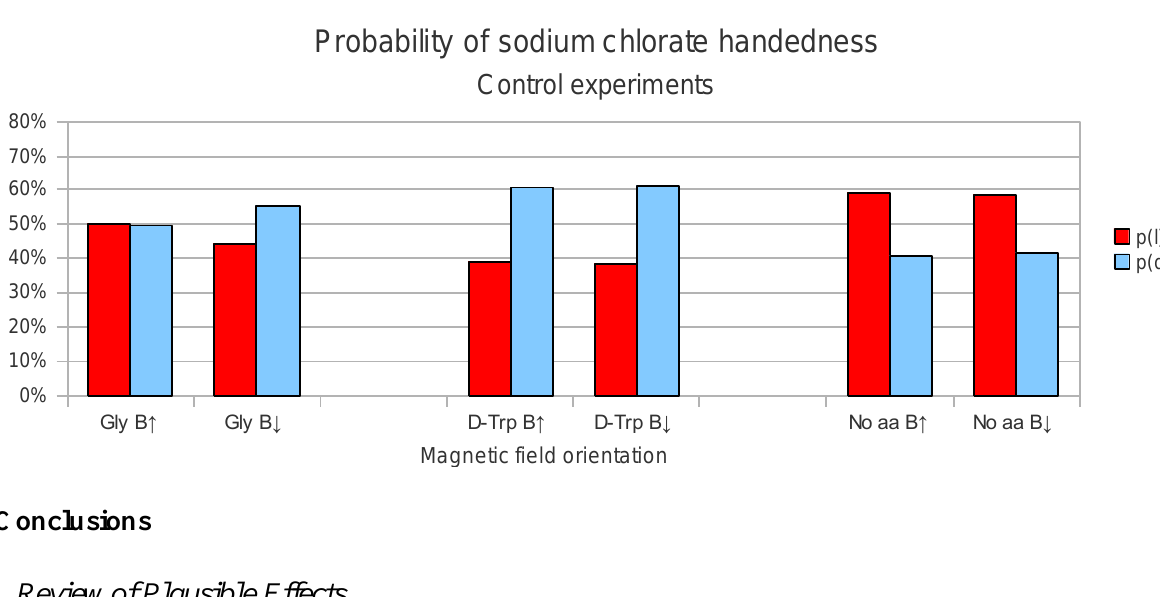
Figure 5. True proportion or probability of sodium chlorate handedness, (l) vs. (d), in the control experiments, as function of the magnetic field orientation and initial solution, with only 20 ppm of the achiral amino acid Gly, with 20 ppm of the chiral amino acid D -Trp or without amino acid and exposed solely to ambient chiral. The preferred handedness does not vary with magnetic field orientation indicating that in these control experiments there is no enantioselective